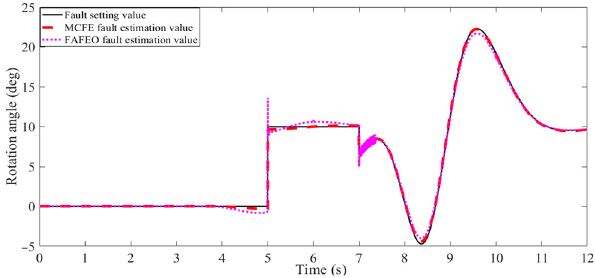
Figure 12 Fault estimation curve of the rotation angle sensor